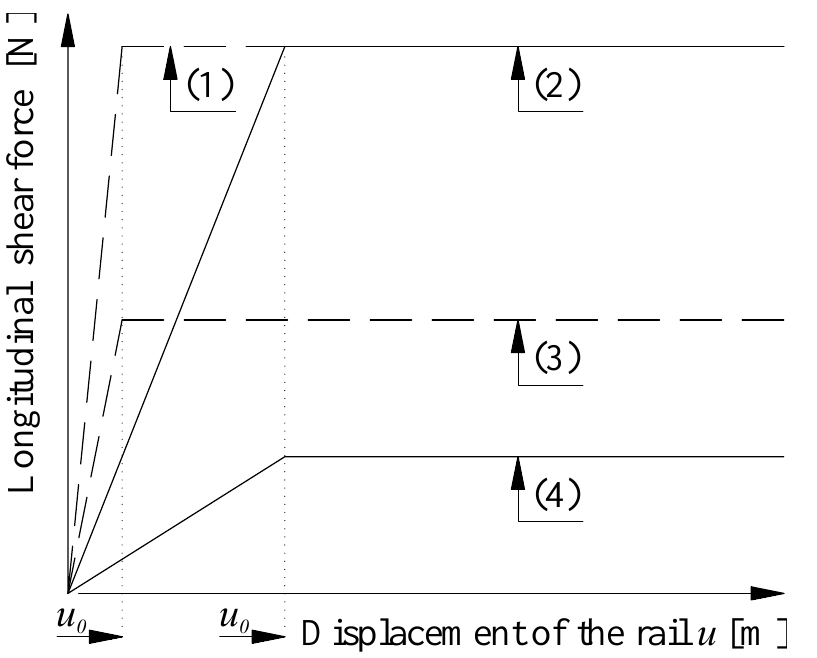
Figure 2. Variation of longitudinal shear force with longitudinal track displacenlellt for one track. (1) Resistance of the rail in sleeper (loaded track without ballast); (2)Resistance of sleeper in ballast (loaded track); (3) Resistance of the rail in sleeper (unloaded track without ballast); (4) Resistance of sleeper in bal1ast (unloaded